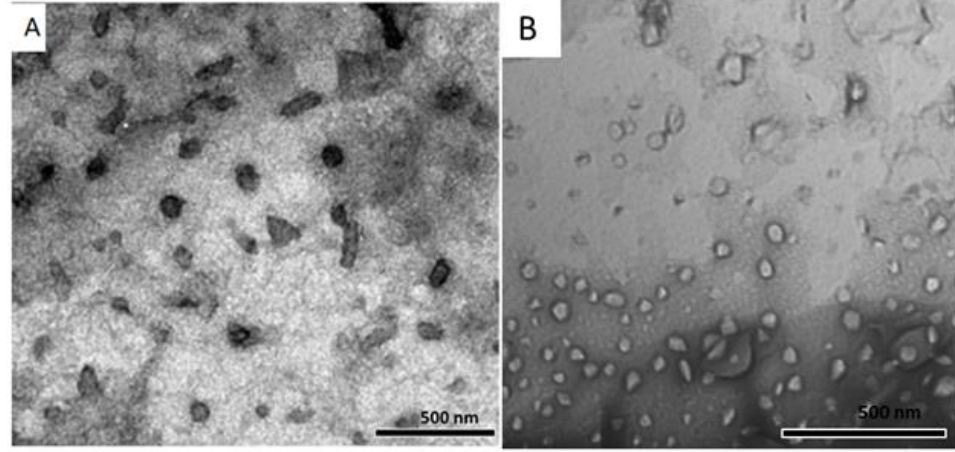
Figure 2. TEM images for ( A ) Ps/BLs and ( B )